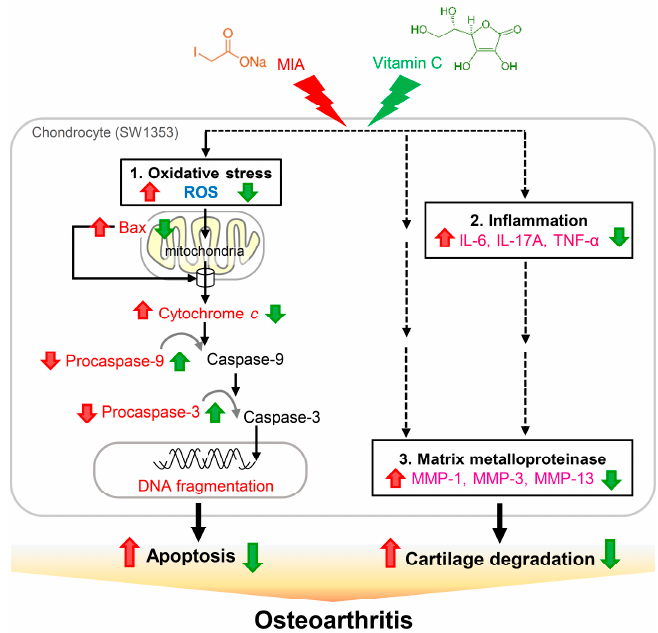
Figure 10. Schematic diagram of vitamin C effects on MIA-treated chondrocytes. The present study demonstrates that, upon 5 μ M MIA exposure to SW1353 cells, ROS, Bax, and cytochrome c release are increased; however, procaspase-9 and procaspase-3 levels are decreased, indicating that caspase-9 and caspase-3 are activated, which leads to increased apoptosis of chondrocytes (1. Oxidative stress). Additionally, the expressions of pro-inflammation cytokines IL-6, IL-17A, and TNF- α (2. Inflammation), and MMPs MMP-1, MMP-3, and MMP-13 are increased (3. Matrix metalloproteinase), which may cause cartilage degradation. These contribute to the occurrence of osteoarthritis. Interestingly, all of these MIA-induced changes can be decreased with vitamin C treatment. Black solid lines indicated evidences found in this study, dashed lines indicated unknown involved actors. Red : enhanced by MIA; Red : decreased by MIA; Green : enhanced by Vitamin C; Green : decreased by Vitamin C.